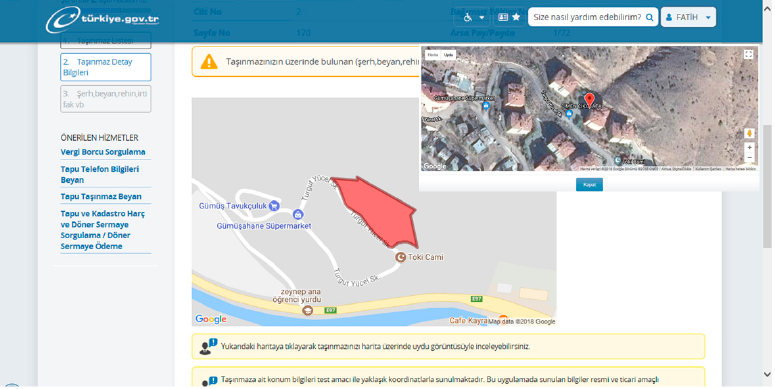
Figure 8. Accessing the information of individual units through e-government. Land 2020 , 9 , x FOR PEER REVIEW